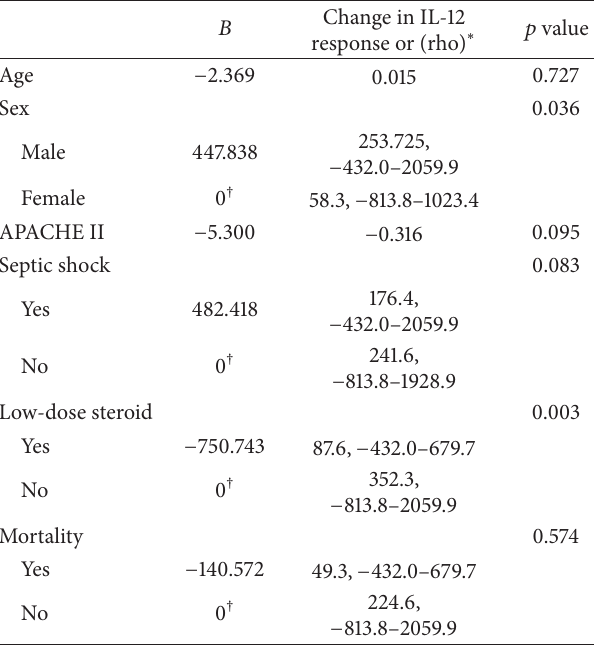
Table 6: Generalized linear model analysis for the change in IL-12 response to identify independent factors among clinical character- istics and steroid